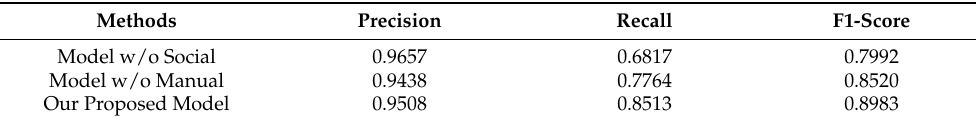
Table 5. Performance of the ablation